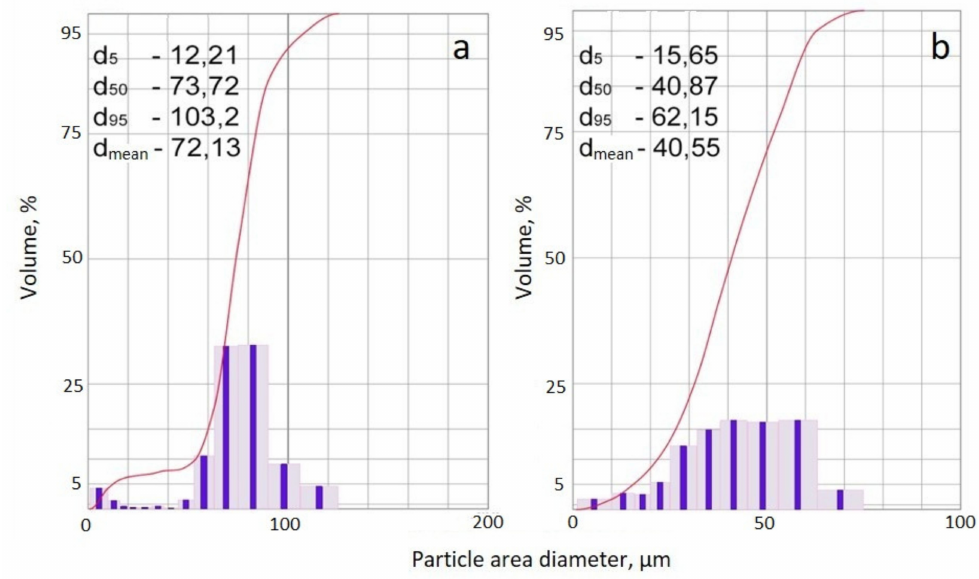
Figure 4. Integral curves and histograms of particle-size distribution of powders: the HN71MTYuB alloy ( a ) and PR-12H18N9T ( b ).